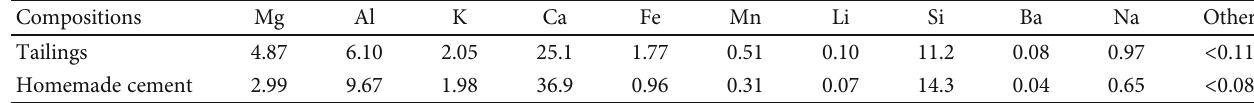
Table 2: Chemical compositions of tailings and homemade cement